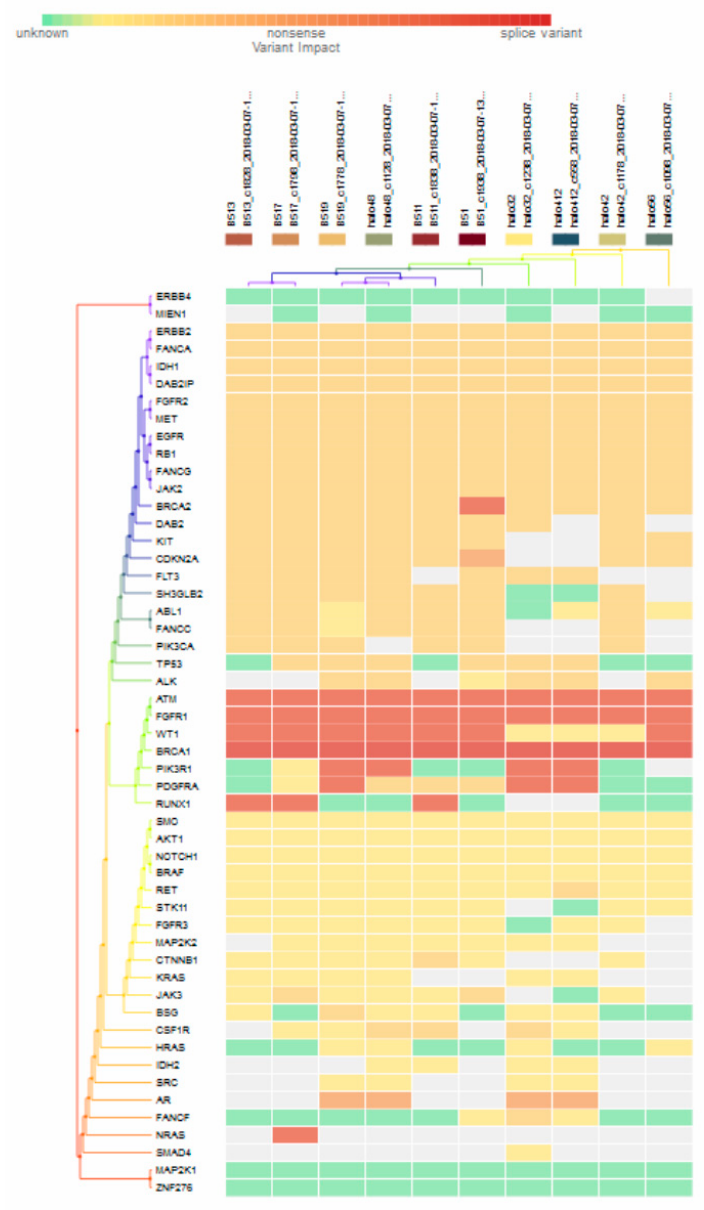
Figure 5. Heat map for 10 HR − /HER2+ subtype breast cancer. The variants impacted in 10 HR- /HER2+ breast cancers were INDELs. Frameshift: BRCA2 (1), ATM, FGFR1 (10), WT1 (7), PIK3R1 (4), PDGFRA (3), RUNX1 (3), NRAS (1); non-frameshift: CDKN2A (1), AR (4); SNPs splice: BRCA1 (10); missense: ERBB2, FANCA, IDH1, DAB21P, FGFR2, MET, EGFR, RB1, FANCG, JAG2 (10), BRCA2 (9), DAB2, KIT (8), CDKN2A, FLT3, SH3GLB2 (7), ABL1, FNACC, PIK3CA, TP53 (6), ALK (5), PDGFRA (3), RET (1), CTNNB1 (1), JAK3 (2), BSG (1), CSF1R (3), FANCF (1).